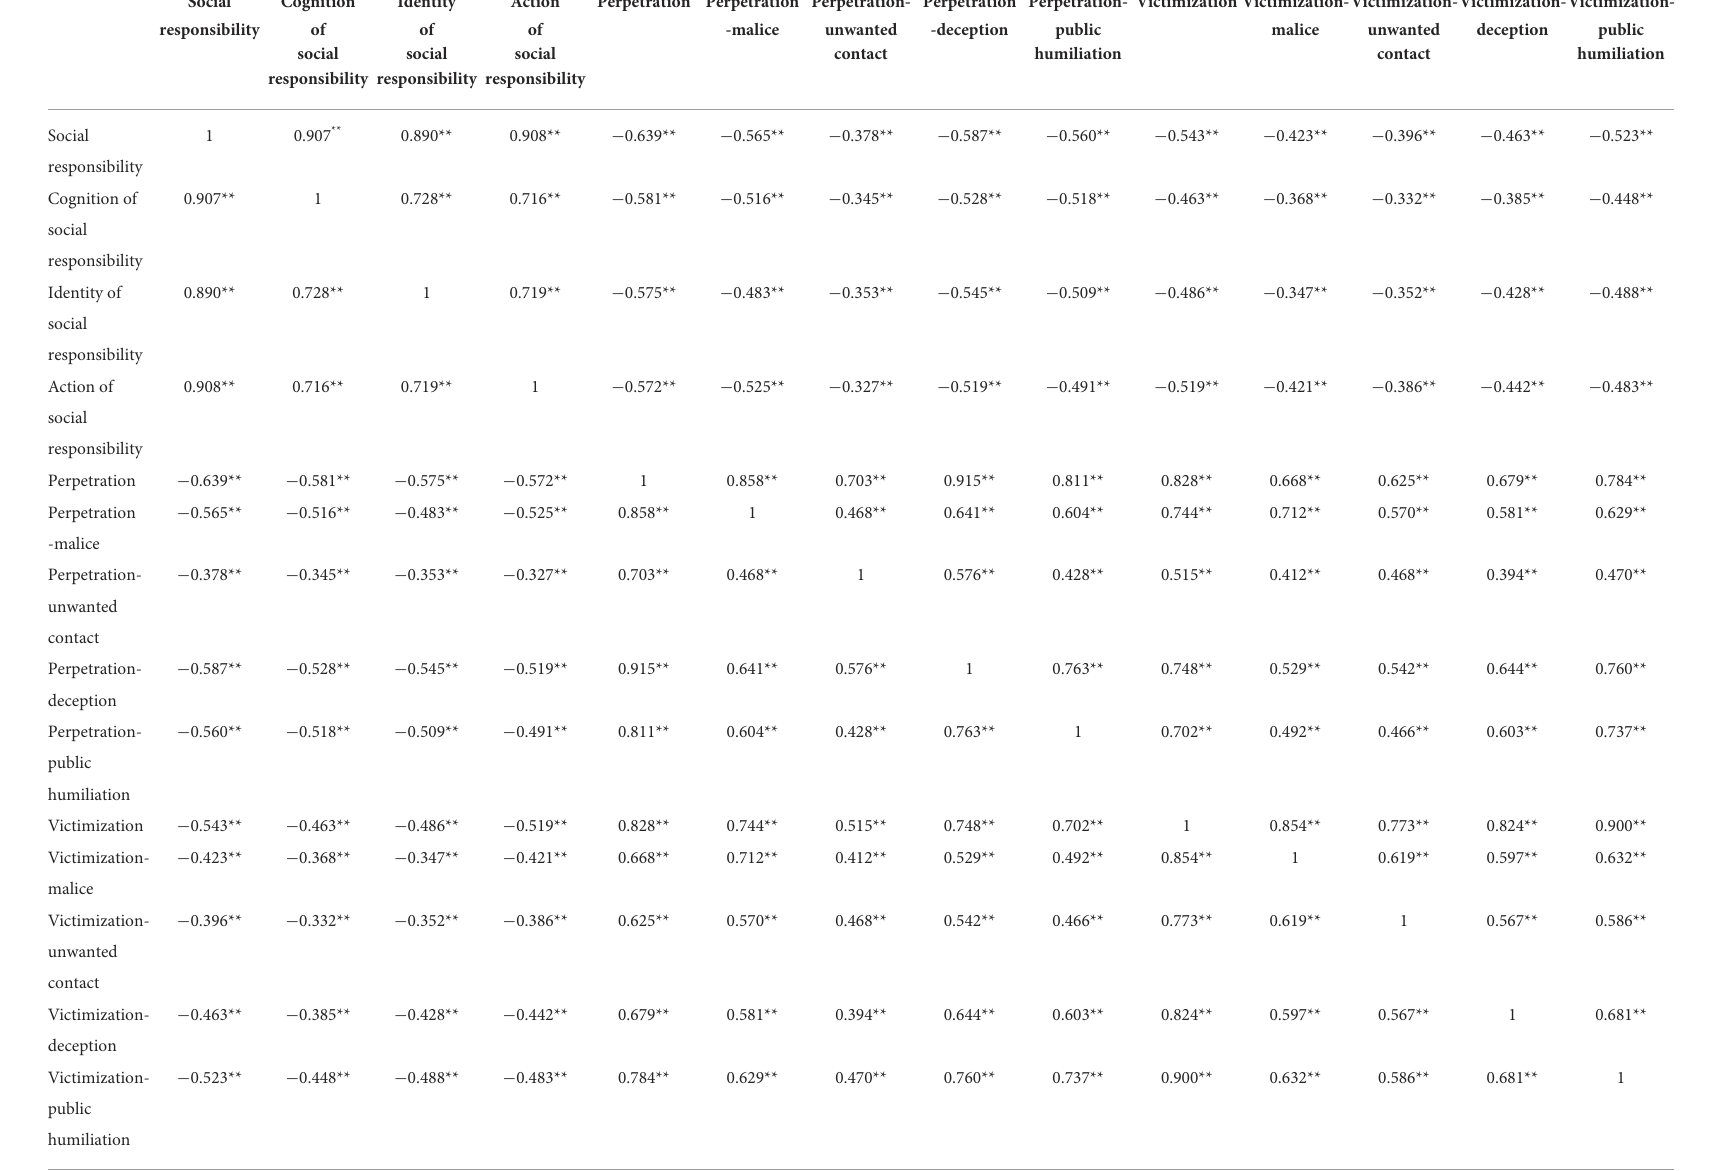
TABLE 2 Correlation analysis among